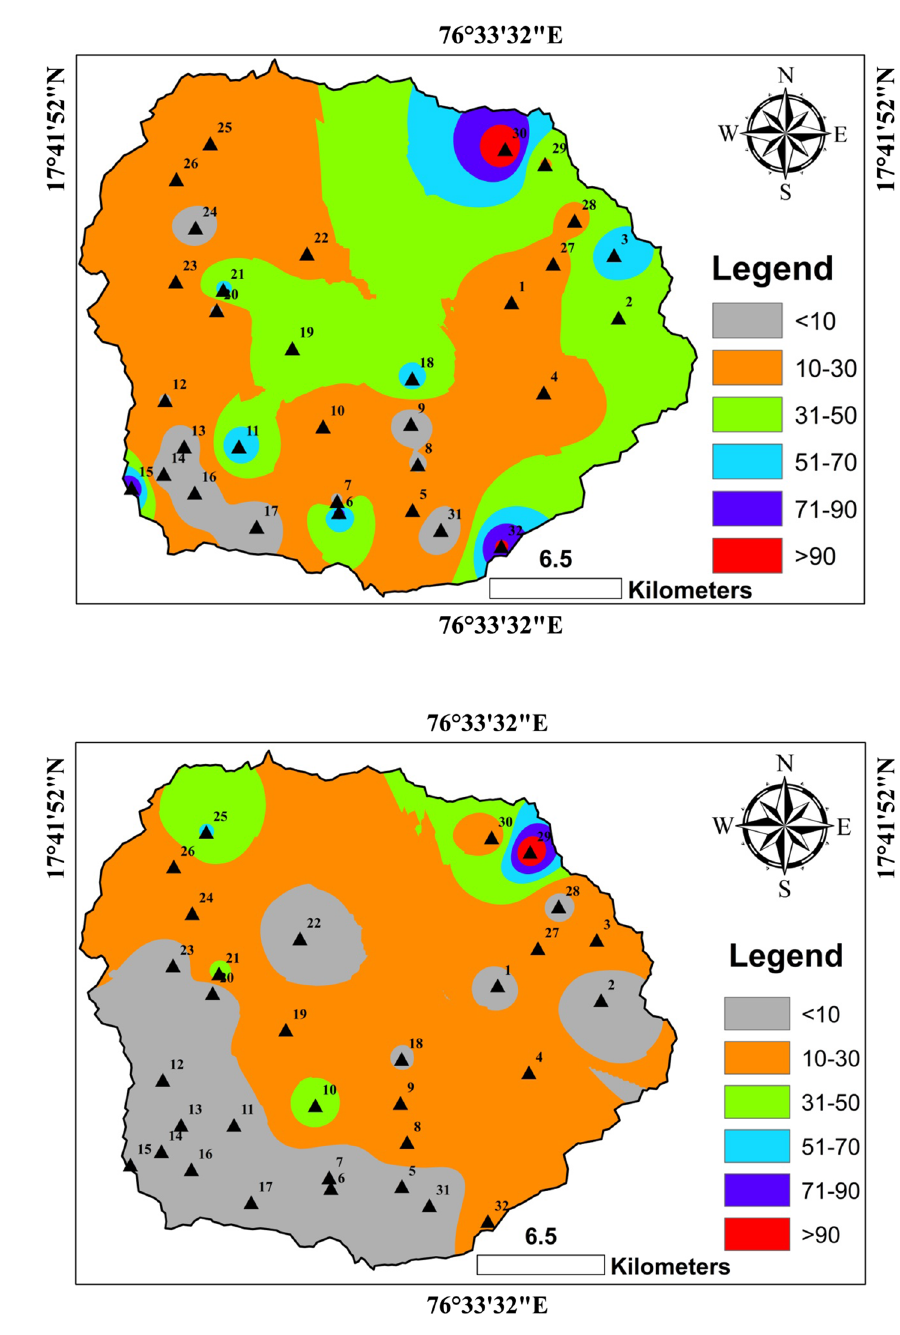
Fig. 10 Geospatial distribution of magnesium (pre-monsoon)